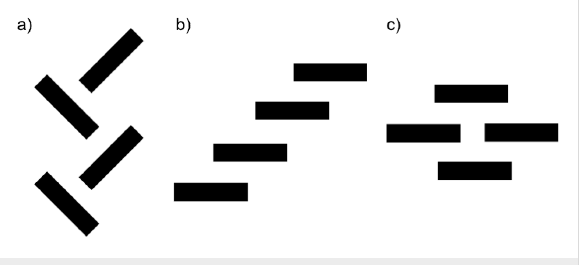
Figure 4: Schematic classification of three common solid-state arrangements of pentacene derivatives a) herringbone packing, b) 1D slipped-stack packing, and c) 2D “bricklayer” packing (as viewed side- on, approximately down the short-molecular axis).